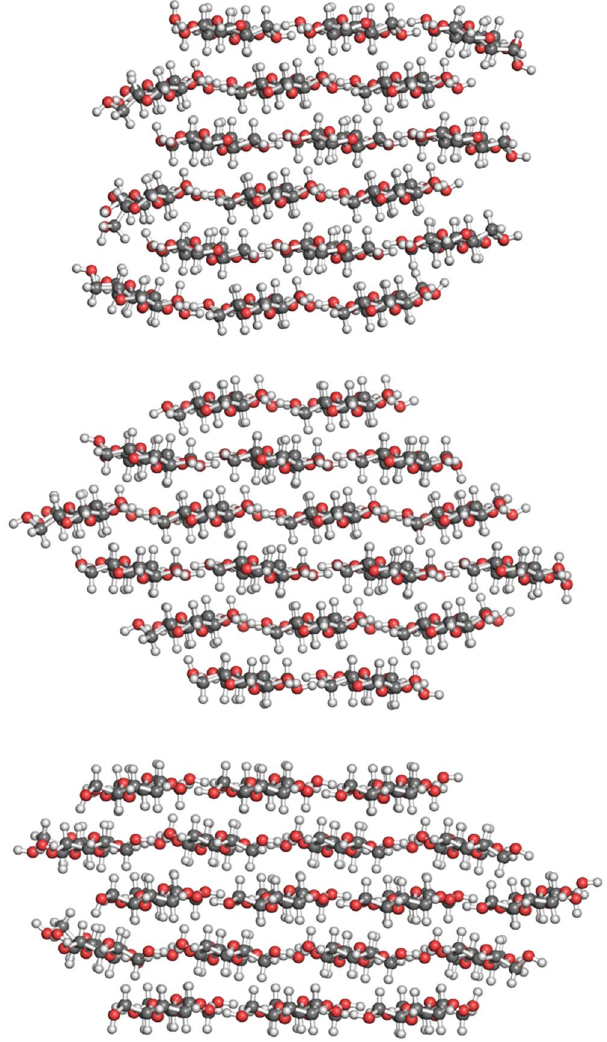
Figure 1. Potential crystal habits of native cellulose microfibrils: 6 × 3, 234432 and 34443 models (from top to bottom).